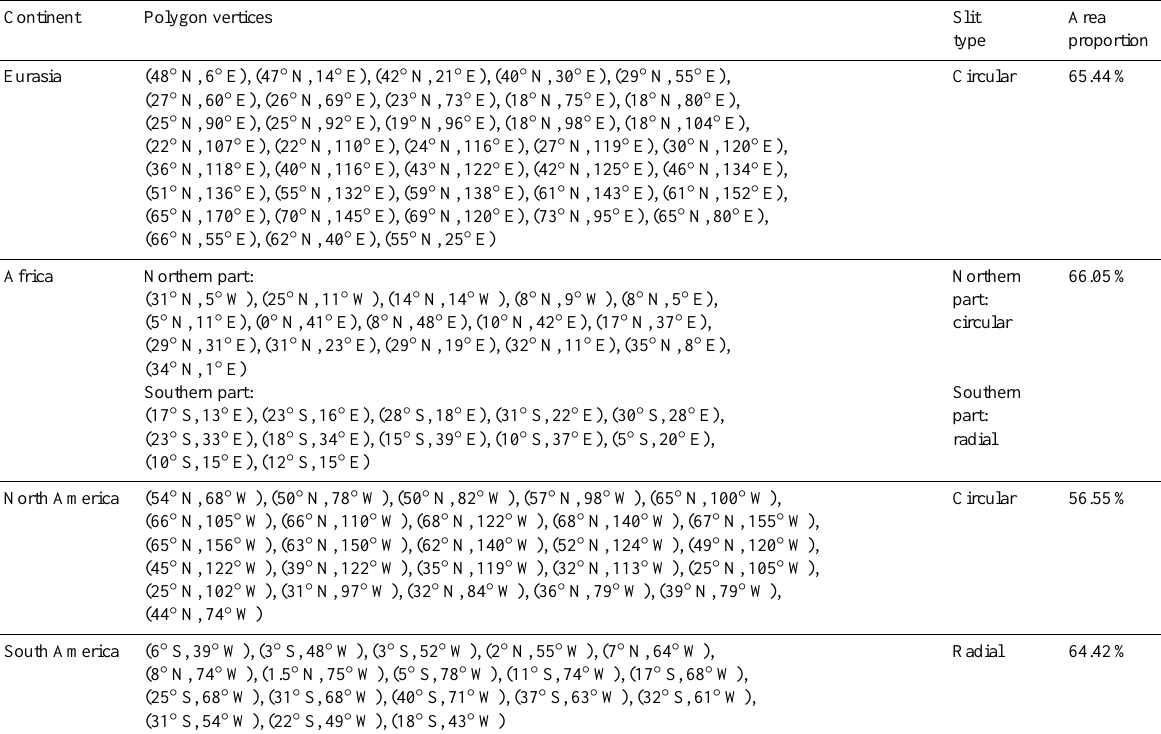
Table 2. Continental boundaries and slit information. Continent Polygon vertices Slit